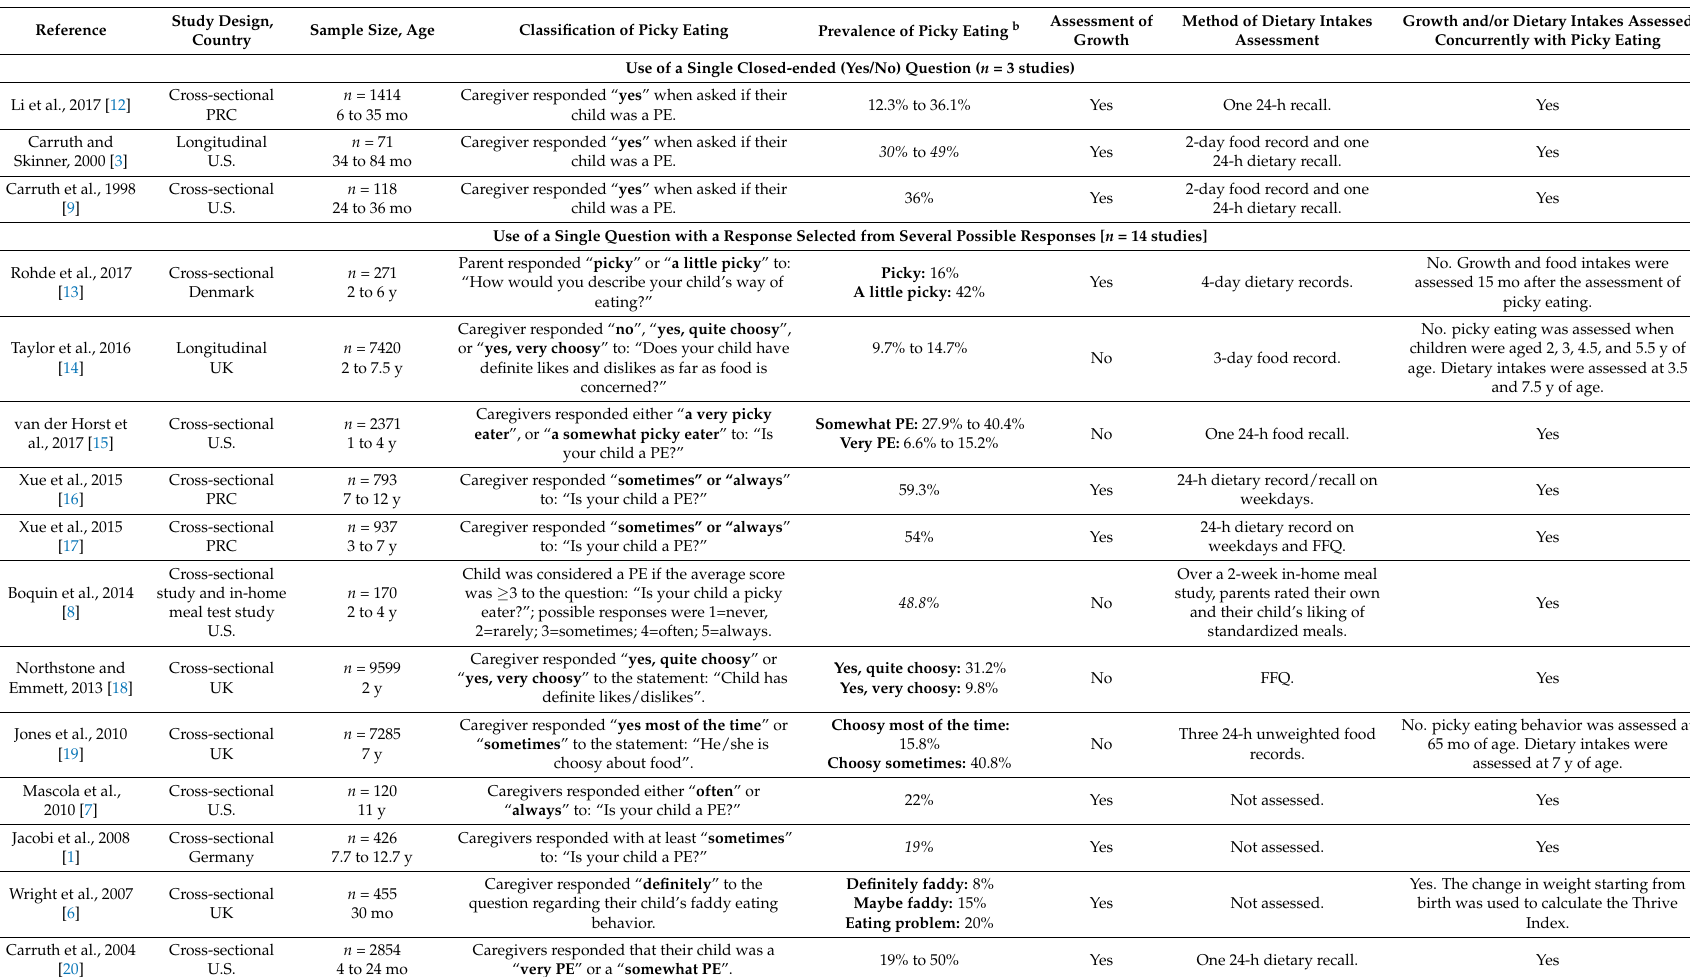
Table 1. Key Characteristics of the Identified Studies a